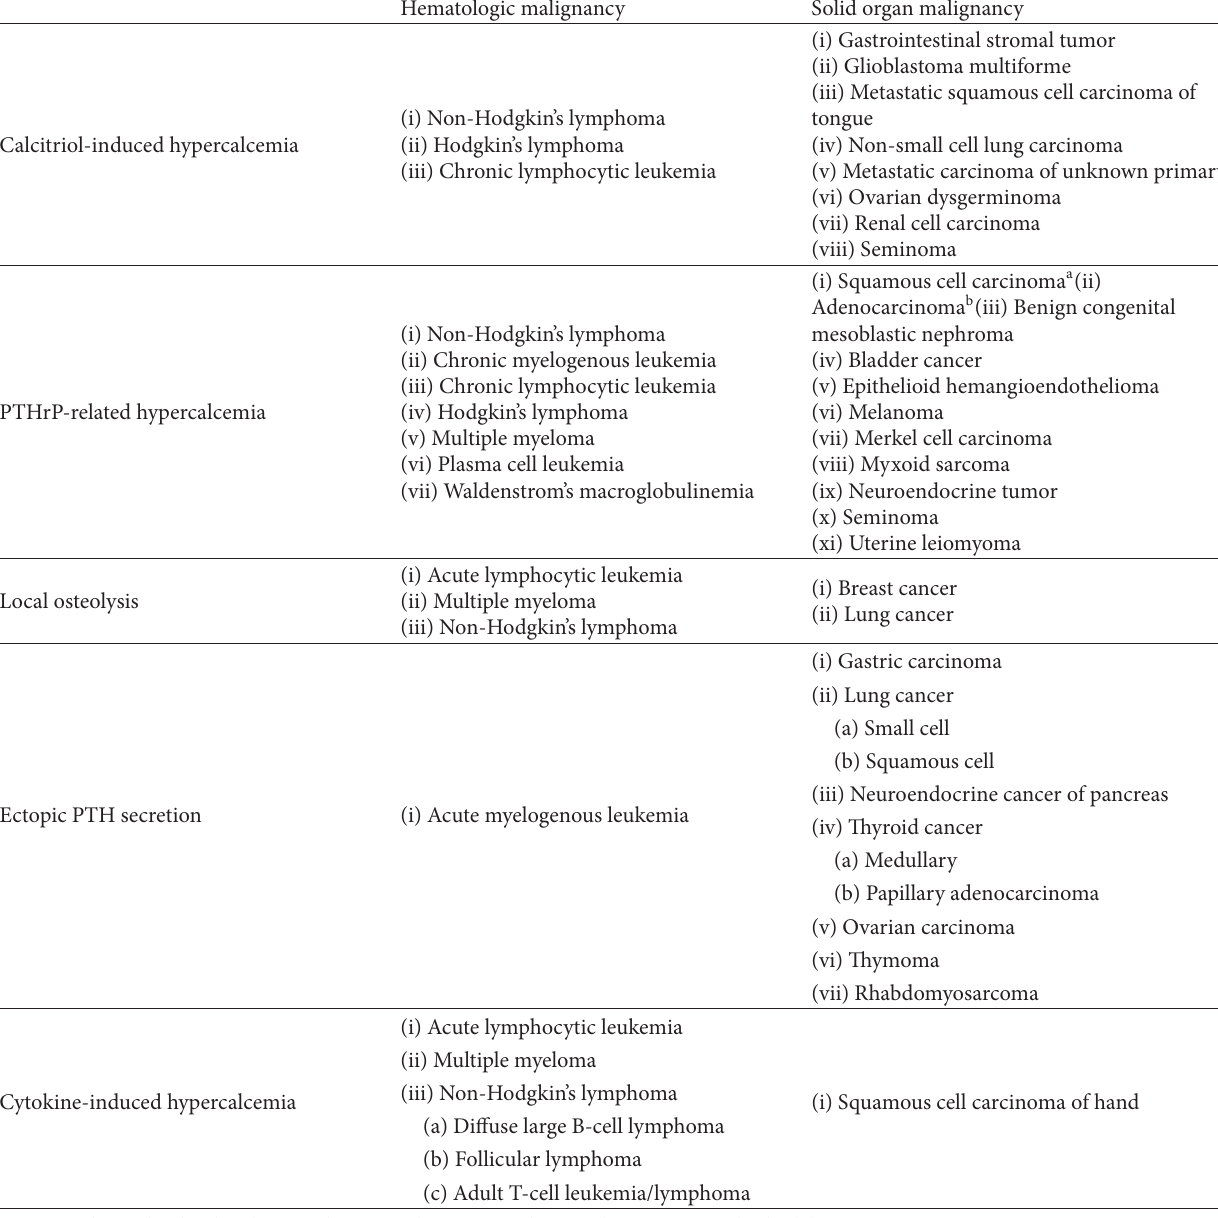
Table 1: Respective cancers associated with mechanisms of hypercalcemia of malignancy [4,